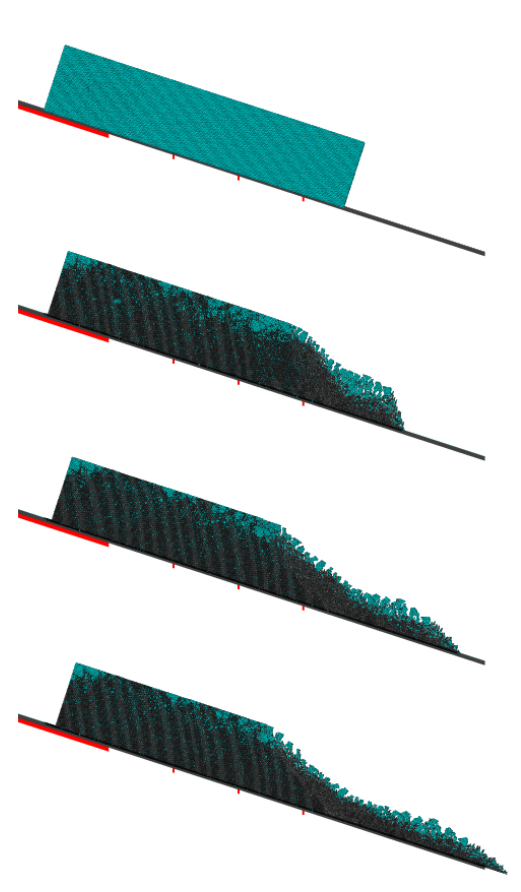
Fig. 7. Similar as in Fig. 6, but with several “frictional anchors”, indicated by red markers, also on the lower part of the